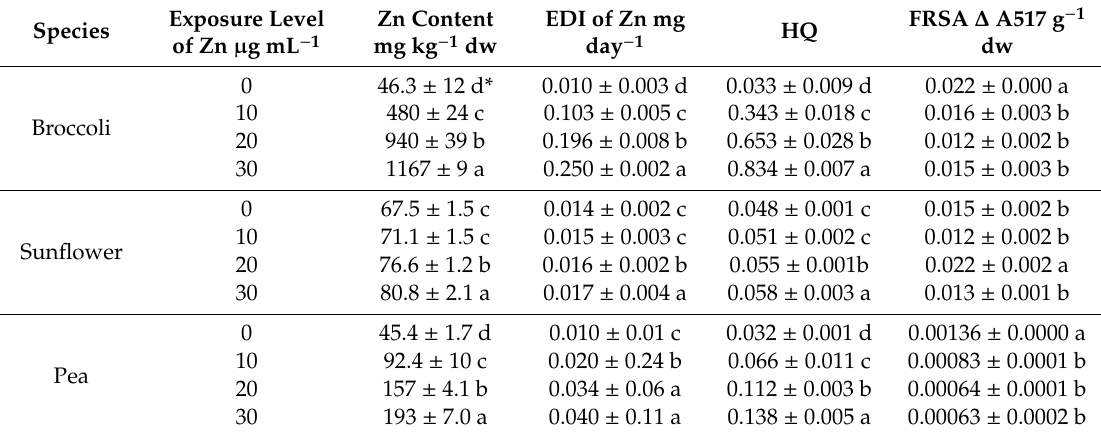
Table 2. Zn content in sprouts, health risk assessment (EDI, HQ) and free-radical scavenging activity (FRSA). The measurements were performed after 4 days (broccoli) and 5 days (pea, sunflower) of germination. Means ± SD from n = 3 for Zn content, for EDI and HQ one replication consisted of 80 seeds for pea and sunflower, and 300 seeds for broccoli. For FRSA, means ± SD from 3 biological replicates from 3 experiments and 3 instrumental replications are